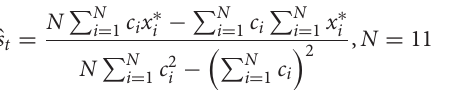
Algorithm (XGB) is a supervised ensemble learning